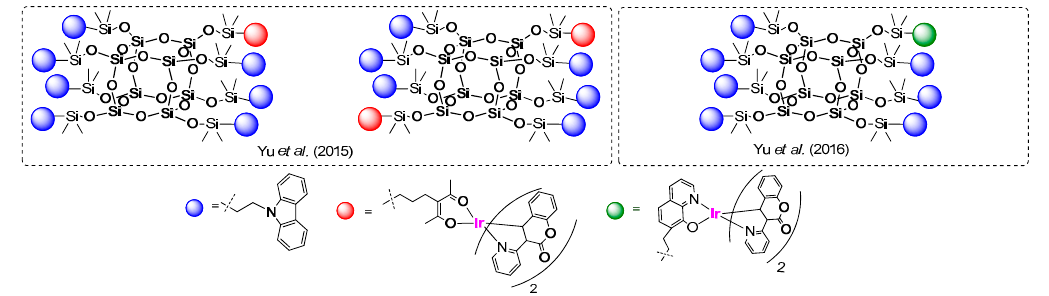
Figure 34. The Ir complexes of spherosilicate obtained through hydrosilylation.